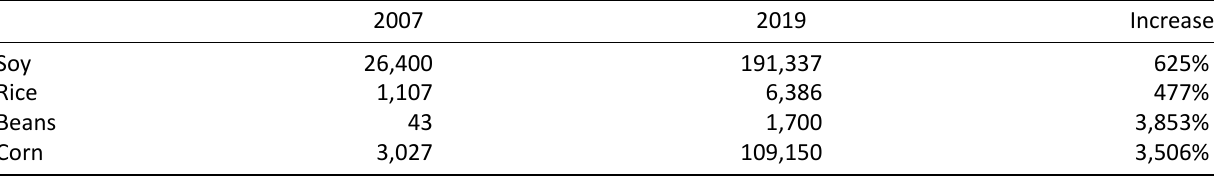
Table 1. Rural production in Santana do Araguaia (tonnes).